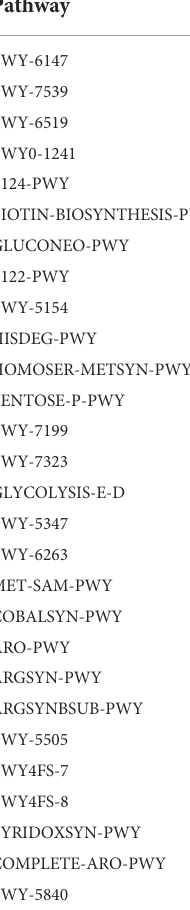
TABLE 1 The functional pathway.